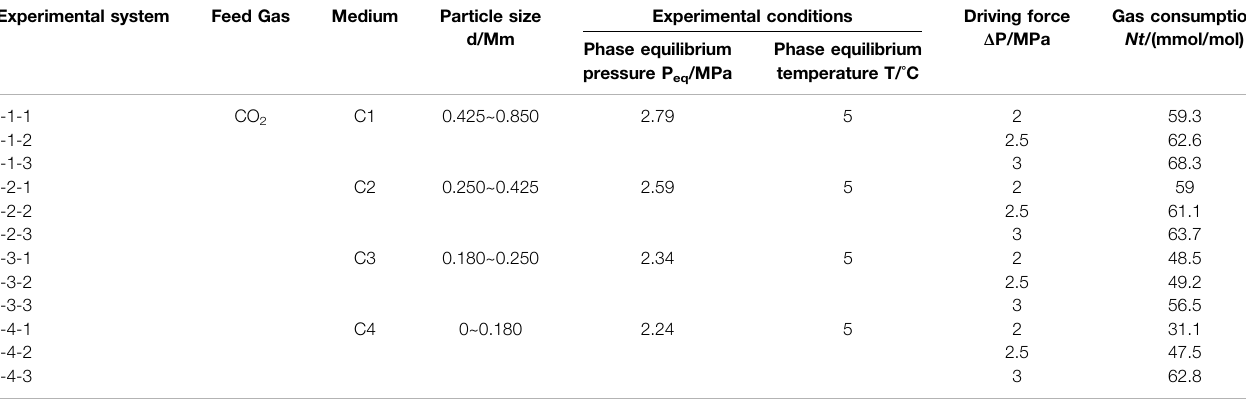
TABLE 1 | Consumption of gas of CO 2 hydrates in coal particles under the different driving forces. Experimental system